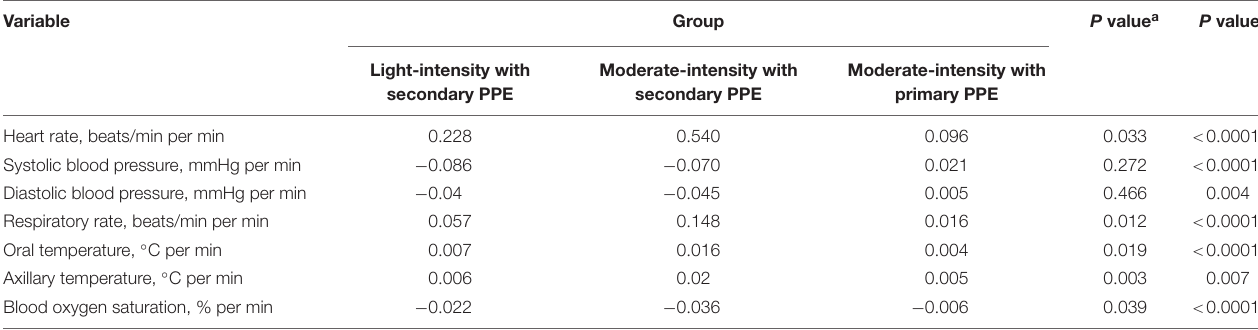
FIGURE 6 | The dynamics of blood oxygen saturation of participants with primary and secondary PPE. ∗∗∗∗ p < 0.0001. The slopes of blood oxygen saturation during the trial were calculated by generalized estimating equations. PPE, personal protective equipment. TABLE 2 | Comparison of the physiological index changes of participants between light-intensity with secondary PPE and moderate-intensity with secondary or primary PPE. Variable Group P value a P value